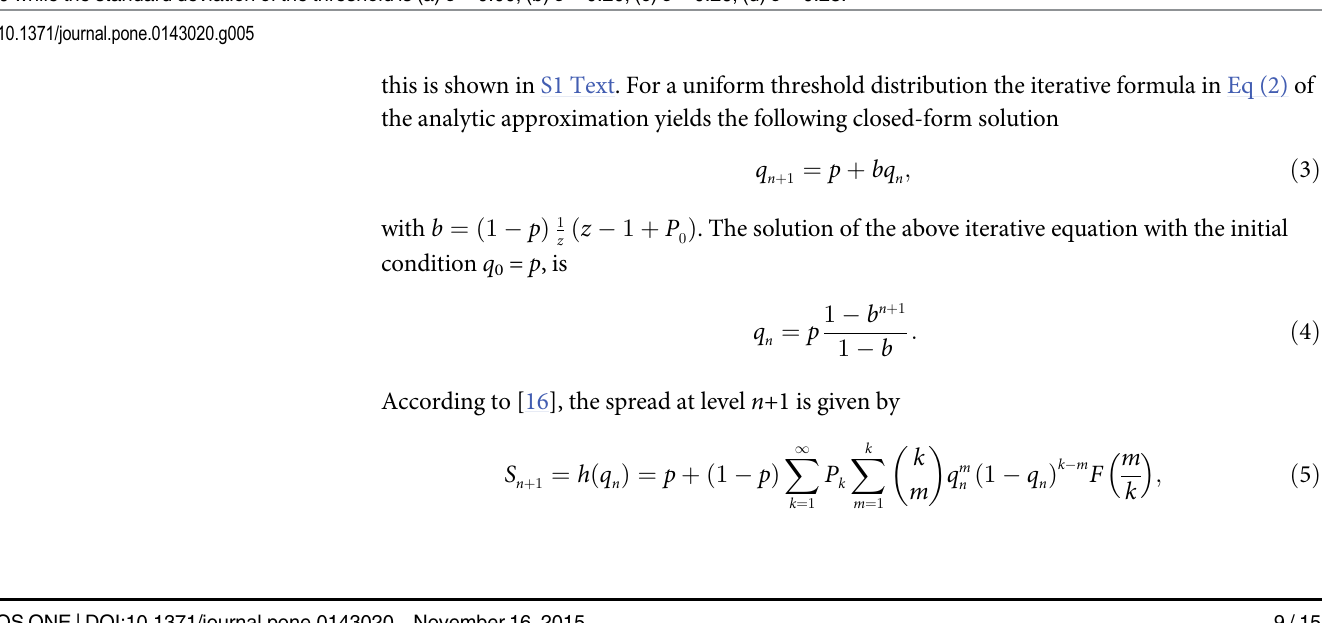
Fig 5. Finite-size behavior of the final cascade size S eq at vs. the initiator fraction p for SF networks with z = 10 and γ = 3. The mean threshold is ϕ 0 = 0.50 while the standard deviation of the threshold is (a) σ = 0.00, (b) σ = 0.20, (c) σ = 0.26, (d) σ =